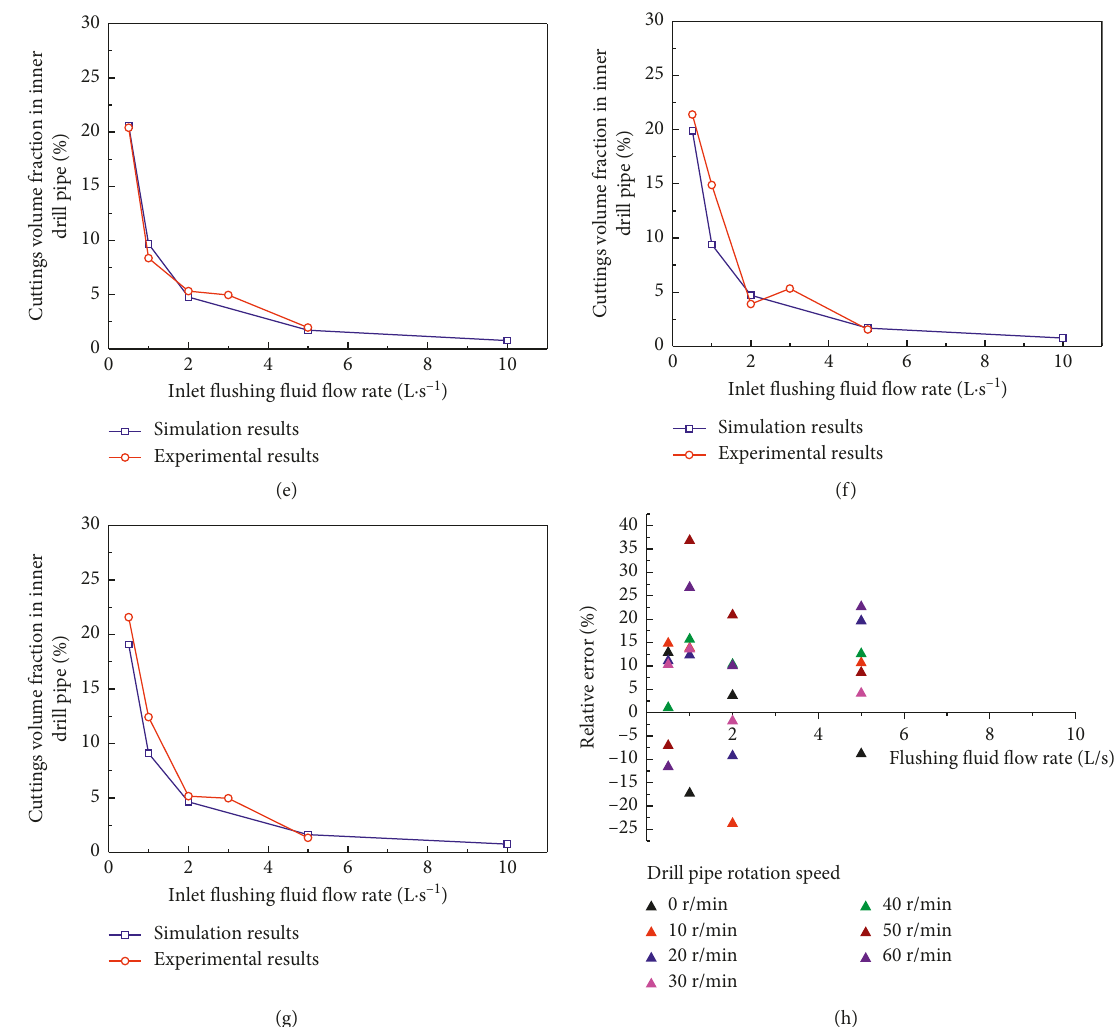
Figure 13: Comparison of simulation results and experimental results when the inclination angle is 90degrees: (a) rotation speed is 0; (b) rotation speed is 10r/min; (c) rotation speed is 20r/min; (d) rotation speed is 30r/min; (e) rotation speed is 40 r/min; (f) rotation speed is 50r/min; (g) rotation speed is 60r/min; (h) the distribution of relative